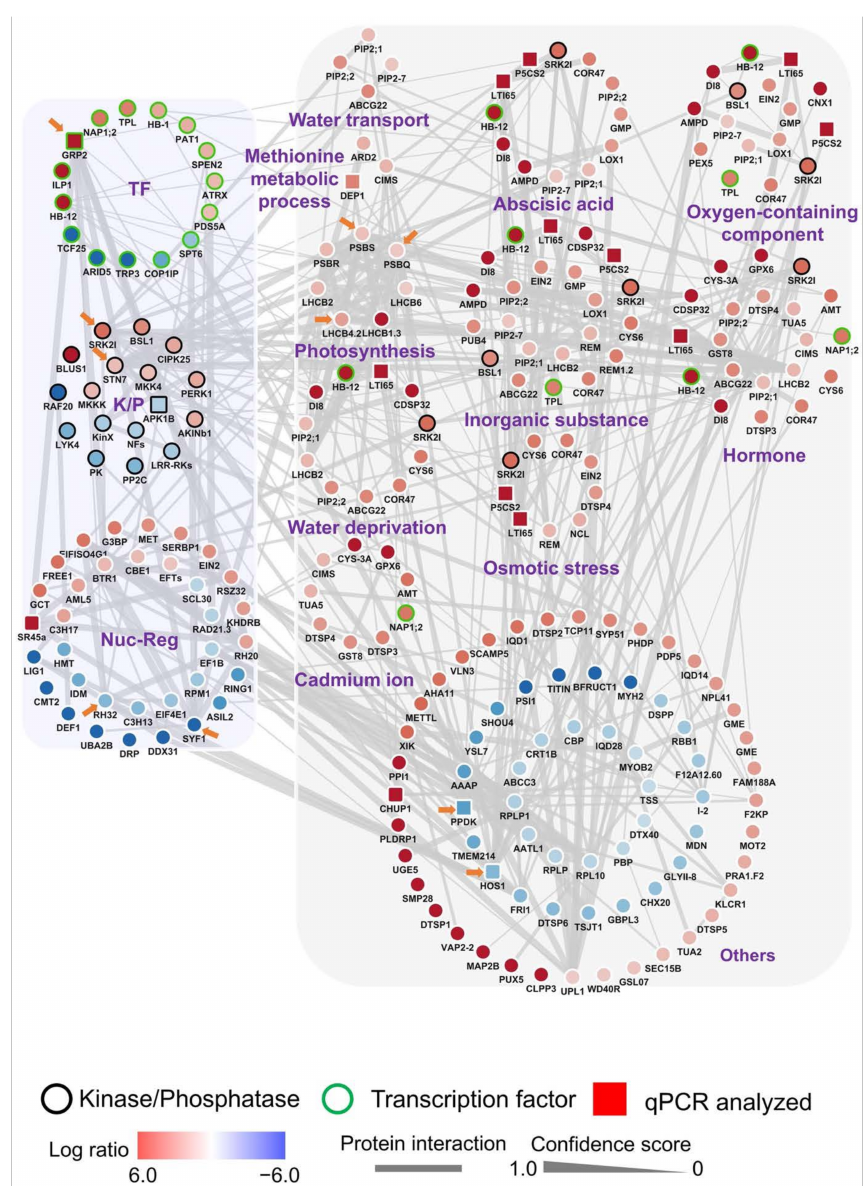
Figure 5. Volvox graphic representation of the putative protein-protein interaction. Both circular and squared node repre- sents a significantly regulated phosphoprotein. The red and blue node stands for the significantly up- and downregulated phosphoprotein, respectively. The color palette indicates the level of protein phosphorylation (Supplementary Table S6a). The squared nodes represent those phosphoproteins analyzed by RT-qPCR (Figure S9). The nodes of black and green border stand for kinase/phosphatase and transcription factor, respectively. The edge represents a probable protein-protein interaction. The interaction is predicted by STRING database [63]. The thickness represents the confidence score ( ≥ 0.4) of interactions (Supplementary Table S6b). The groups of phosphoproteins of the same function classified according to GO analysis are depicted into Volvox colony-like circle(s). The leftmost three Volvox colonies represent three groups of regulatory phosphoproteins, whereas the rest Volvox colonies represent the functional groups with fold change larger than 3.57 and p value smaller than 0. The TF, K/P and Nuc-Reg represents transcription factor, kinase/phosphatase and nuclear regulator, respectively. The phosphoproteins enriched by multiple functional groups from GO analysis are dispersed simultaneously and in parallel into multiple Volvox colonies. The number of enrichments into each functional group is indicated in the Supplementary Table S6. The arrows point at the top five connected phosphoproteins of both regulatory and response